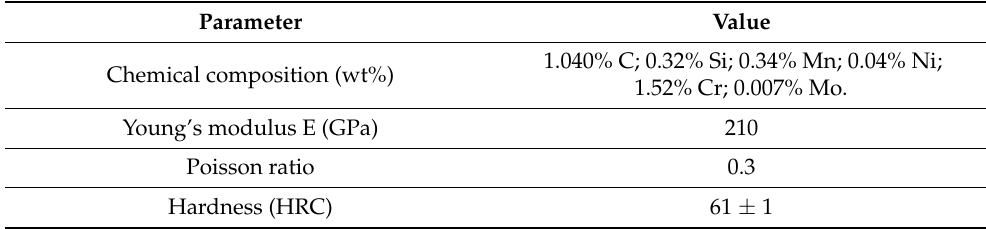
Table 1. Material properties of AISI 52100.